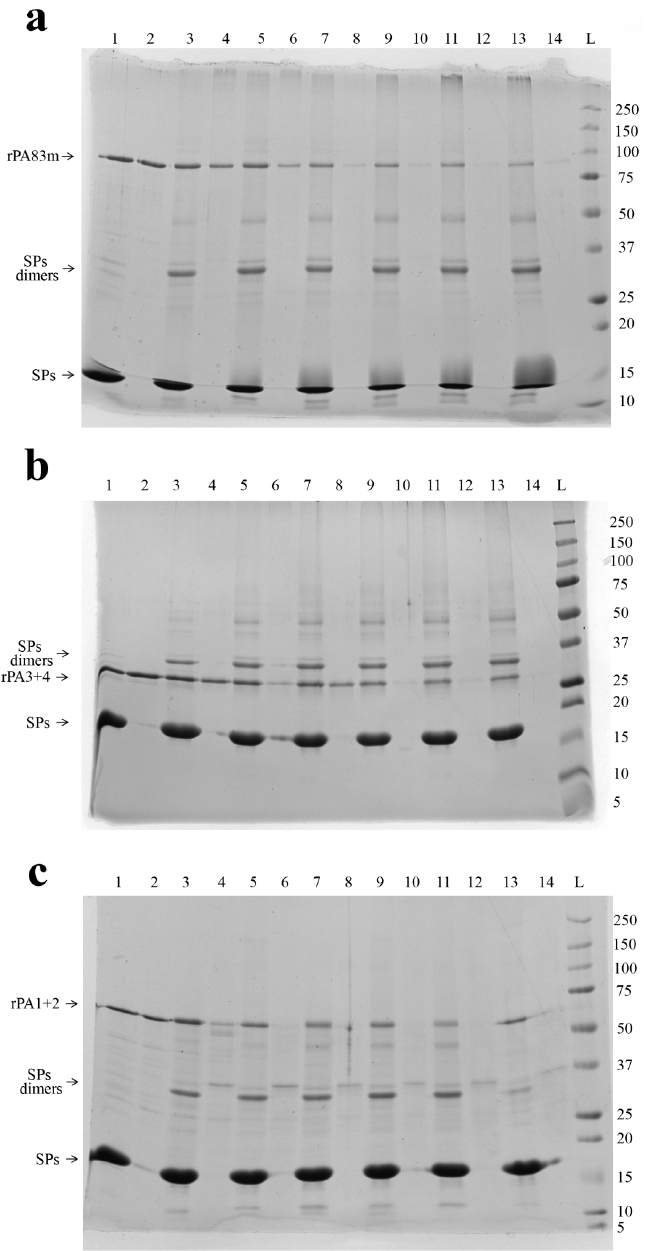
Figure A1. Replicates for comparative stability of SPs-antigen compositions and individual antigens at +37 ◦ C for rPA83m ( a ), rPA3+4 ( b ) and rPA1+2 ( c ). ( a – c )—replicates for the results represented in Figure 7. ( a )—1, 3, 5, 7, 9, 11, 13—rPA83m within SPs-rPA83m compositions incubated at +37 ◦ C for 0, 9, 15, 21, 27, 33 and 40 days, respectively. 2, 4, 6, 8, 10, 12, 14—Individual rPA83m incubated at +37 ◦ C for 0, 9, 15, 21, 27, 33 and 40 days, respectively. L—Protein molecular weight markers ladder (molecular weights, in kDa, are indicated on the right). ( b )—1, 3, 5, 7, 9, 11, 13—rPA3+4 within SPs-rPA3+4 compositions incubated at +37 ◦ C for 0, 10, 20, 25, 30, 35 and 40 days, respectively. 2, 4, 6, 8, 10, 12, 14—Individual rPA3+4 incubated at +37 ◦ C for 0, 10, 20, 25, 30, 35 and 40 days, respectively. L—Protein molecular weight markers ladder (molecular weights, in kDa, are indicated on the right). ( c )—1, 3, 5, 7, 9, 11, 13—rPA1+2 within SPs-rPA1+2 compositions incubated at +37 ◦ C for 0, 10, 20, 25, 30, 35 and 40 days, respectively. 2, 4, 6, 8, 10, 12, 14—Individual rPA1+2 incubated at +37 ◦ C for 0, 10, 20, 25, 30, 35 and 40 days, respectively. L—Protein molecular weight markers ladder (molecular weights, in kDa, are indicated on the right). Relative analysis of recombinant proteins quantity is presented in Table